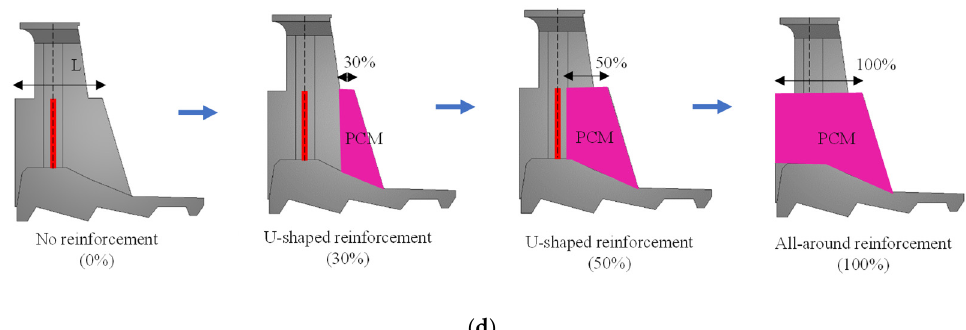
Figure 20. Reinforcement range: ( a ) TYPE-A dam model; ( b ) TYPE-B dam model; ( c ) TYPE-C dam model; ( d ) TYPE-D dam model.